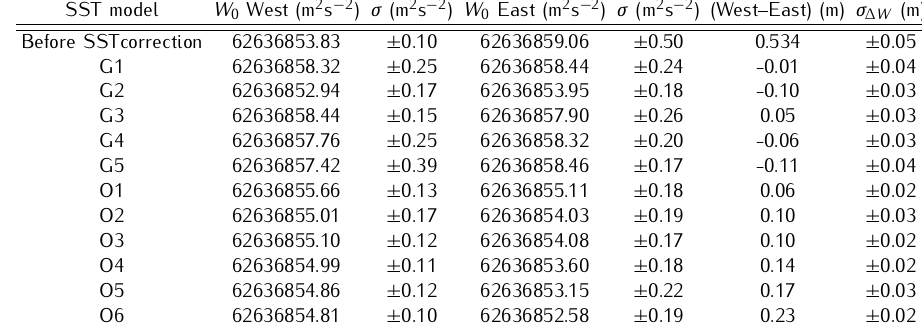
0 before and after SST correction.